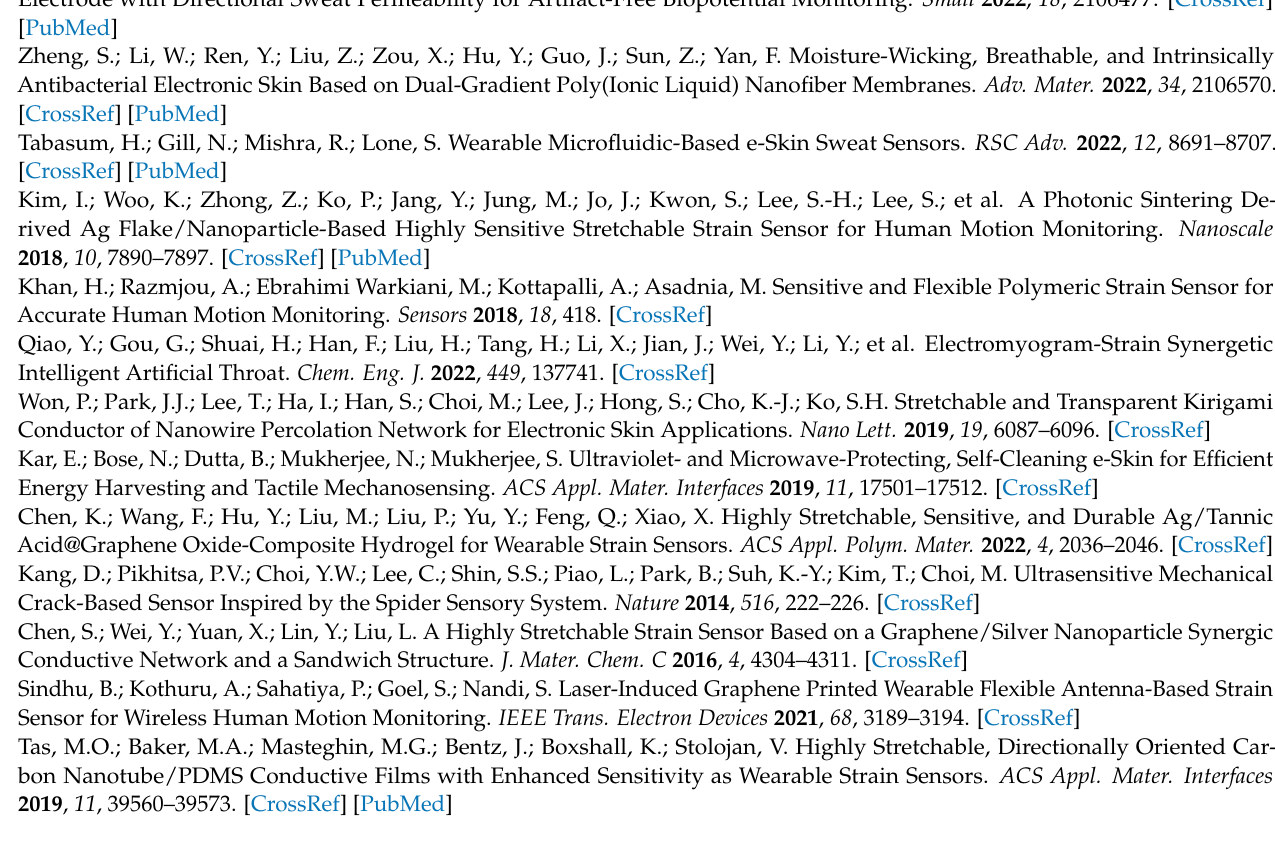
Figure S2: The digital picture of the SCG e-skin.; Figure S3: The comparison between the initial audio wave of animal sound and the corresponding sound vibration signal.; Figure S4: Response towards English word from a loudspeaker. Figure S5: Throat muscle movement detected by SCG e-skin attached to the